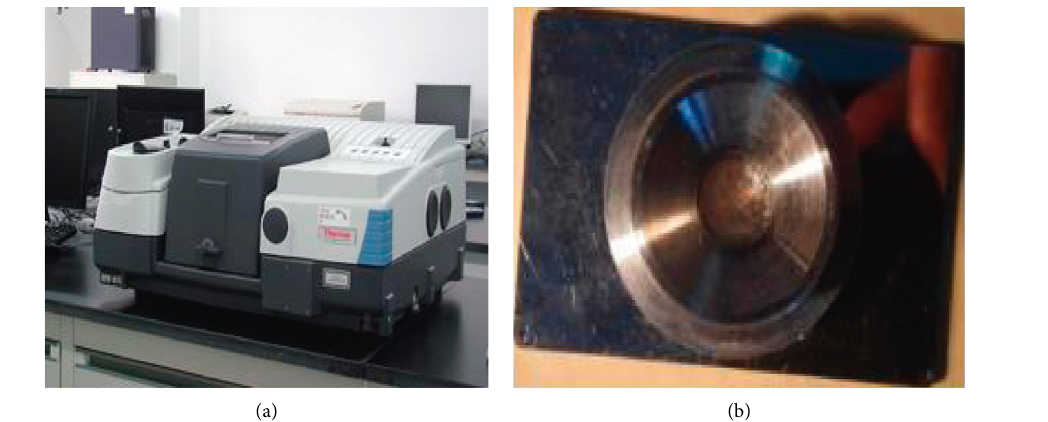
Figure 5: Fourier transform infrared spectrometer characterization: (a) the equipment and (b) test